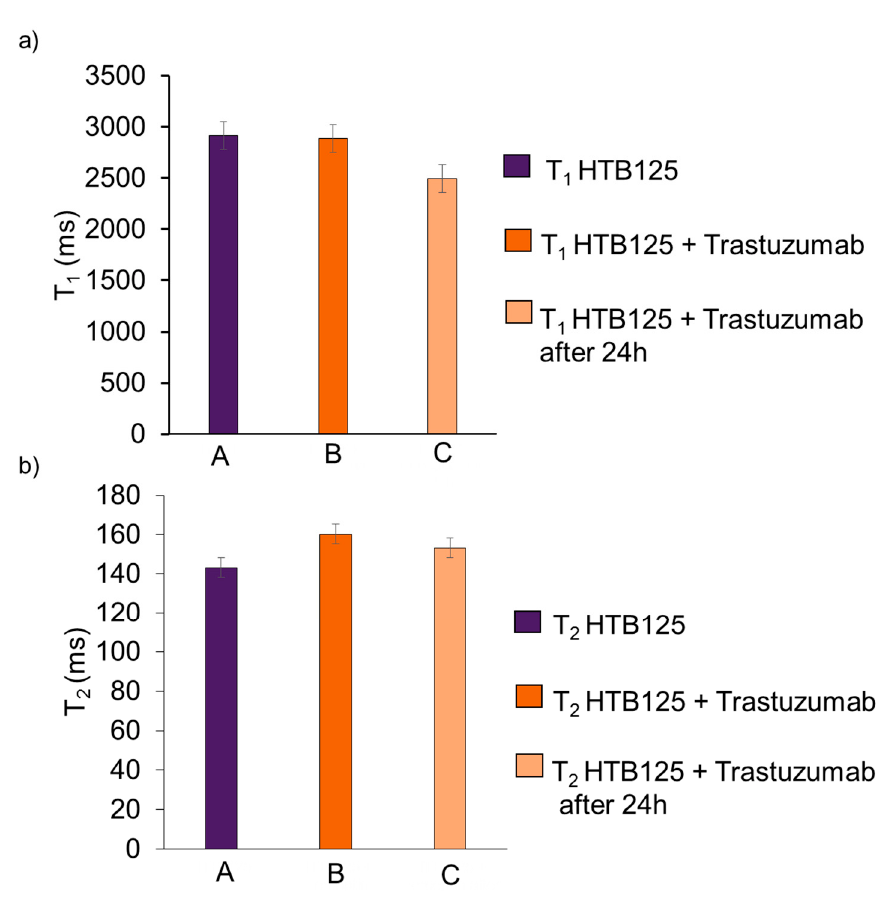
Figure 8. Results of T 1 ( a ) and T 2 ( b ) relaxation times for HTB-125 cell culture (A), and the same culture with the addition of Trastuzumab (B), along with the results after 24 h (C). The graph below shows the results of relaxation times for the HTB-125 cell culture, and the same culture with the addition of synthesized drugs Trastuzumab, along with the results after 24 h (Figure 9).